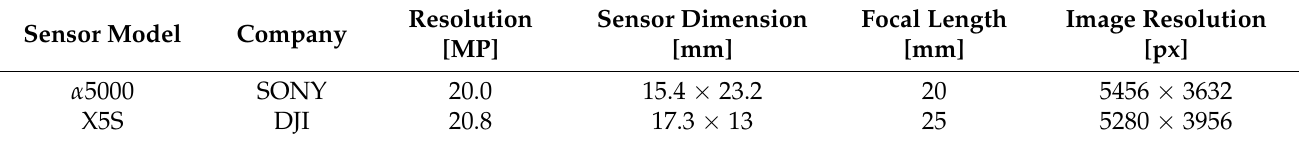
Table 1. Characteristics of the cameras employed for the surveys.